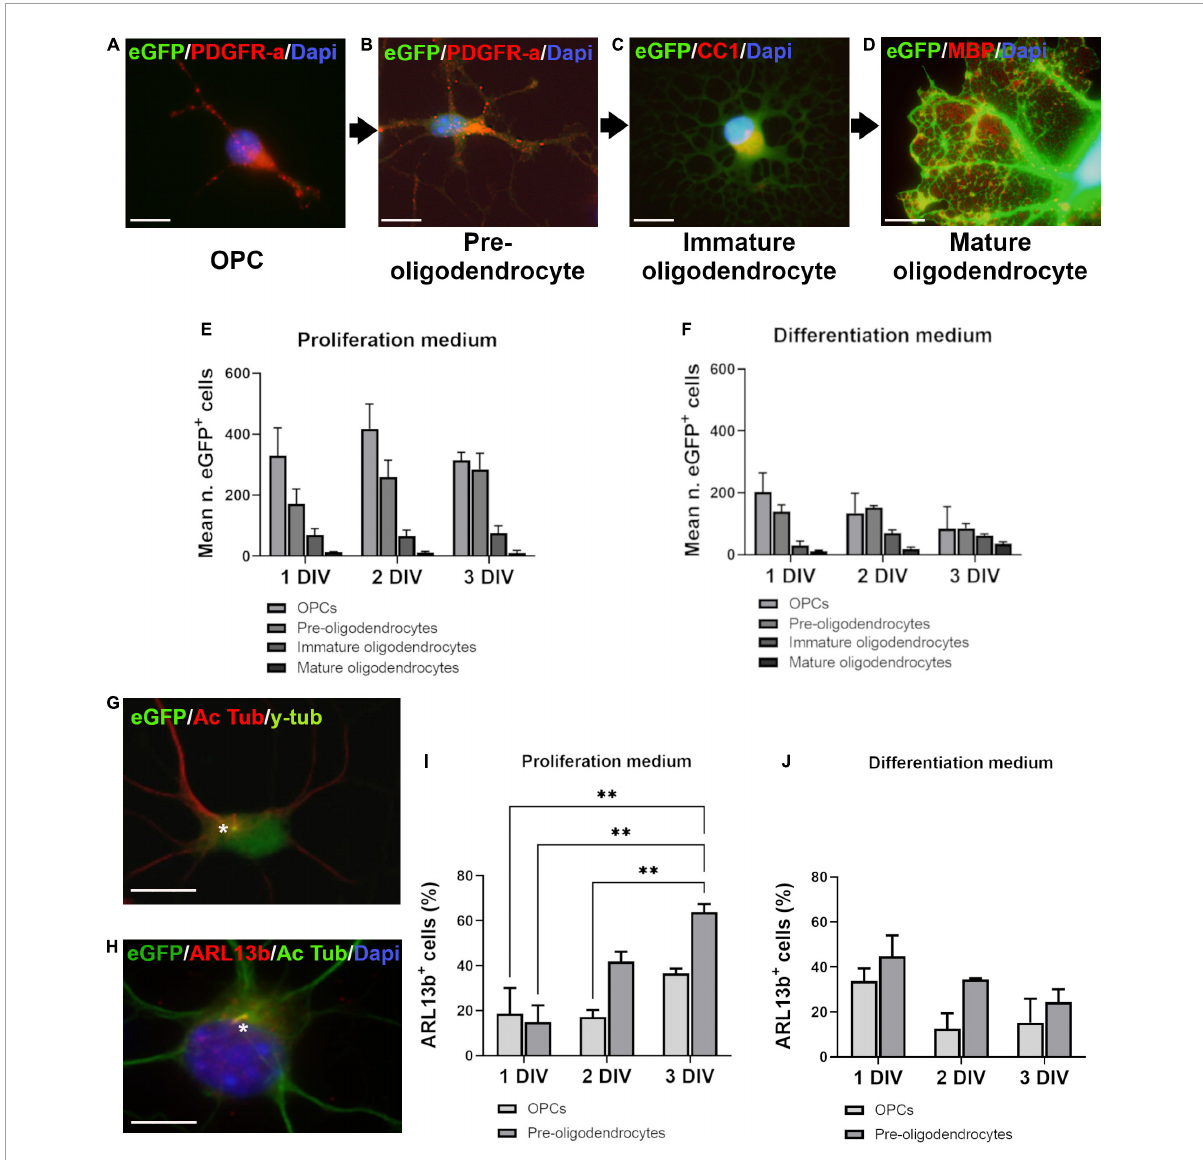
FIGURE1 Ciliated cells in proliferation and differentiation media. (A–D) Oligodendroglial cells in culture were classified in four stages according to branching development, eGFP intensity and markers expression. PDGFR-a + cells were divided in two stages: very weakly fluorescent bipolar cells (OPCs) (A) and more intensely fluorescent multipolar cells with short processes (pre-oligodendrocytes) (B) . Immature oligodendrocytes were CC1 + /MBP − , intensely fluorescent highly branching cells (C) . The late stage cells were brightly fluorescent mature oligodendrocytes characterized by large flat membrane sheets, MBP + (D) . (E,F) Distribution of eGFP + cells in proliferation and differentiation media at three times of culture (days in vitro : DIV). Statistical significance was determined by Chi-Square Test ( χ 2 ). Proliferation medium: df 83.26, p < 0.001***; Differentiation medium: df 242.9, p < 0.001 ∗∗∗ . Graphs in (E,F) represent de mean number of eGFP + cells analyzed in three coverslips from three independent experiences for each time. (G,H) Representative images of OPCs after double staining for acetylated tubulin (Ac Tub)/y-tubulin (G) and Ac Tub/ARL13b (H) . Stars indicate cilia. (I,J) Quantification of ARL13b + /PDGFR-a + cells respectively in proliferation (I) and differentiation medium (J) . Statistical significance was determined by two-way ANOVA and Bonferroni post-hoc test was employed for multiple comparisons. Data are presented as mean ± error of the mean (SEM) and asterisks indicate: ∗∗ p < 0.01. Scale bar is 10 µ m in (A–C) , 5 µ m in (D) , 10 µ m in (G,H)